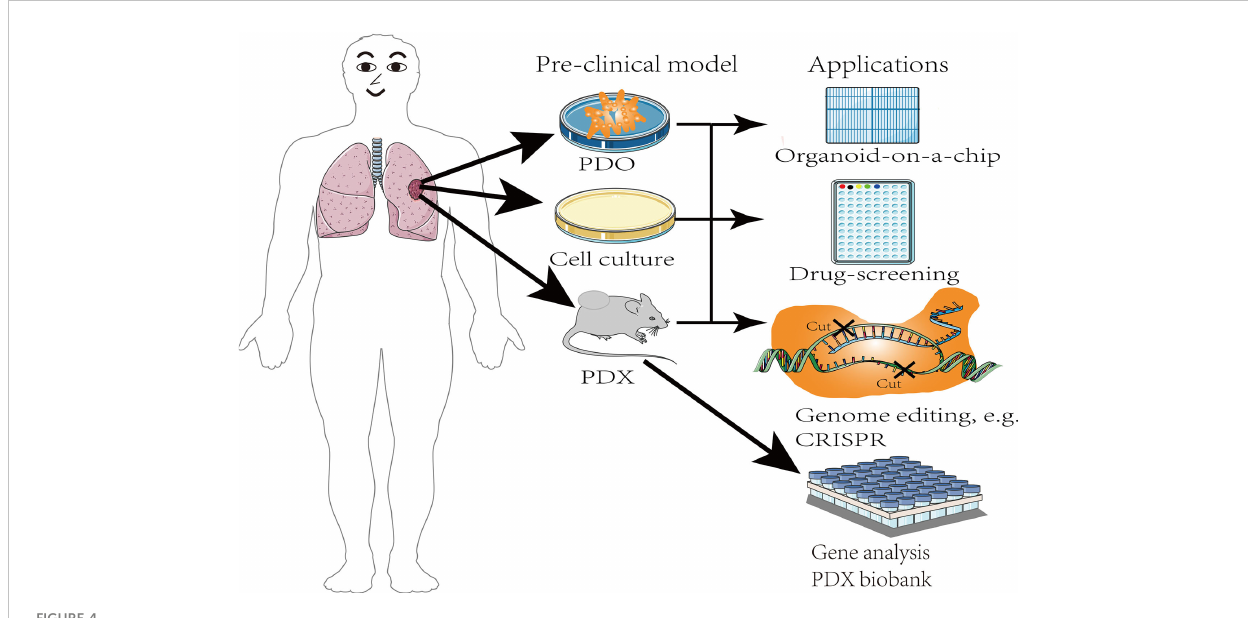
FIGURE 4 The applications of pre-clinical